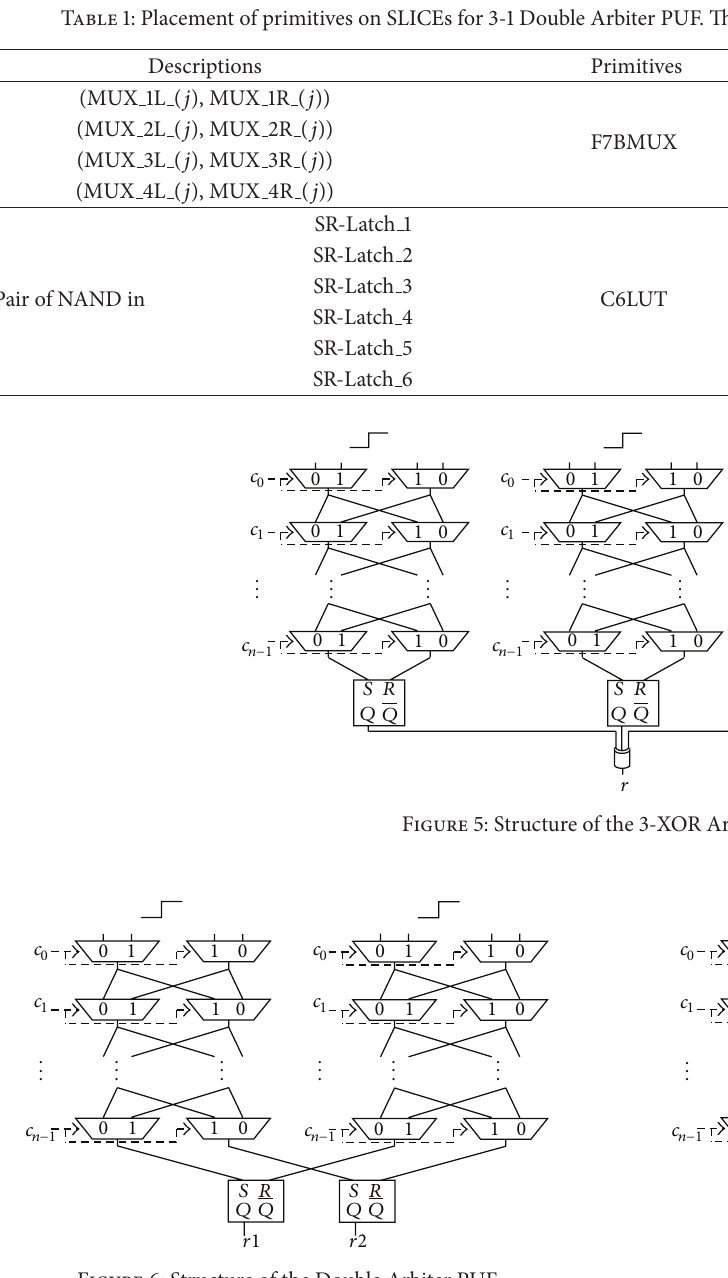
Figure 6: Structure of the Double Arbiter PUF.